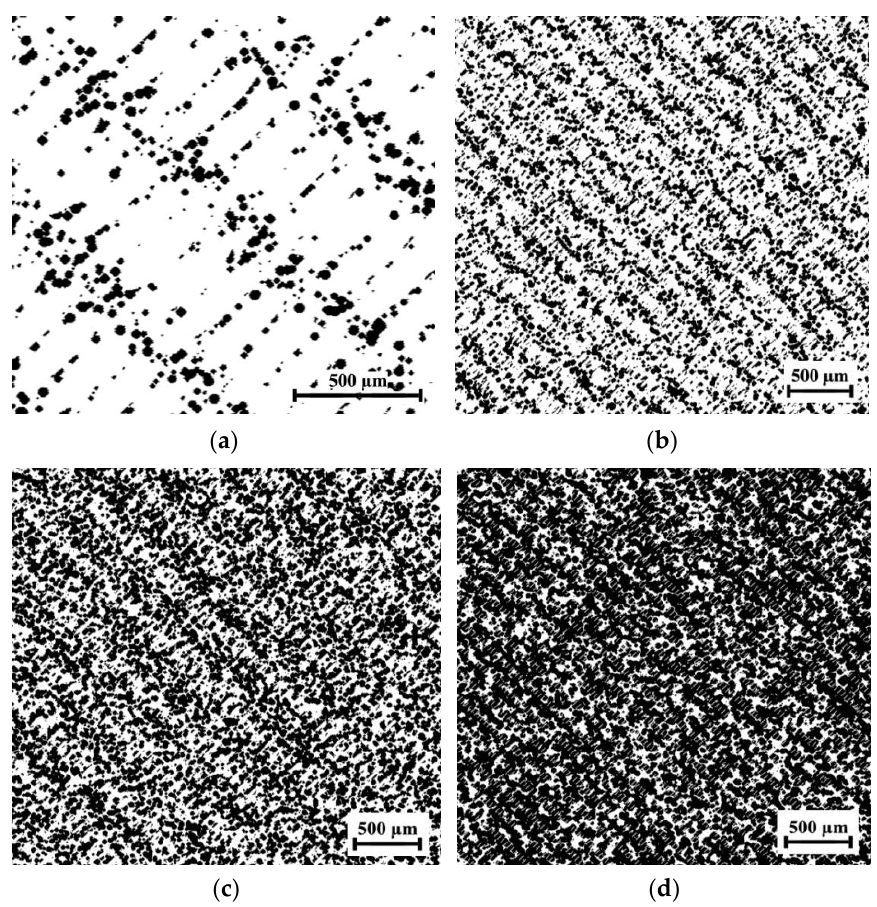
Figure 4. Results of computer modeling of the segregated structure of PLA/CB composite depending on evolution of CB content φ : 1 vol.% ( а ), 2.5 vol.% ( b ), 5 vol.% ( c ), and 7 vol.% ( d ).